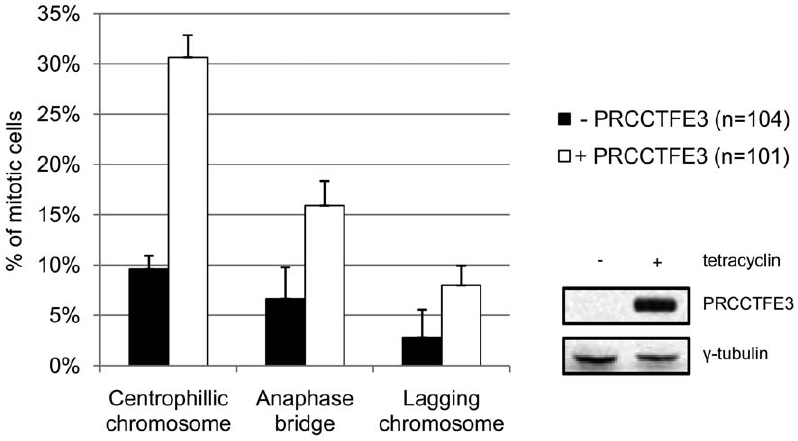
Figure 5. PRCCTFE3 expression leads to mitotic defects. HEK293/T-REx/PRCCTFE3 cells were transiently transfected with a H2B-RFP construct (see Materials and methods) and grown with or without tetracyclin ( + / 2 PRCCTFE3), respectively. Subsequently, mitotic cells were scored for misaligned chromosomes. Percentages of cells with misalignments, such as centrophilic chromosomes, anaphase bridges and lagging chromosomes, are shown in the histogram. Black bars represent un-induced cells (- PRCCTFE3), and white bars represent induced cells ( + PRCCTFE3). In the right panel, PRCCTFE3 protein expression in the induced ( + tetracyclin) cells is shown.